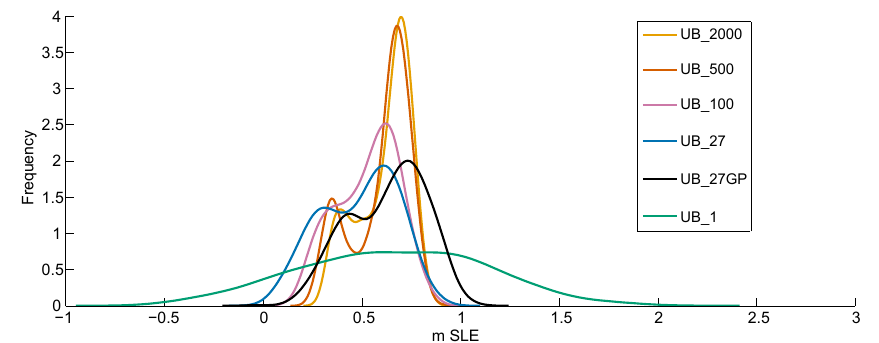
Figure 2. PDF of Antarctica SLE (m) contribution after 100 years, for 800 individual simulations sampled with UB and various partition configurations. The distribution results are from sampling experiments in which we vary the number and configuration of the sampling regions (partitions) (comparing experiments UB_2000, UB_500, UB_100, UB_27, UB_1, and UB_27GP). See Fig. S3 for plots of the spatial configuration of partitions for these experiments. See Table 3 for statistics relating to each